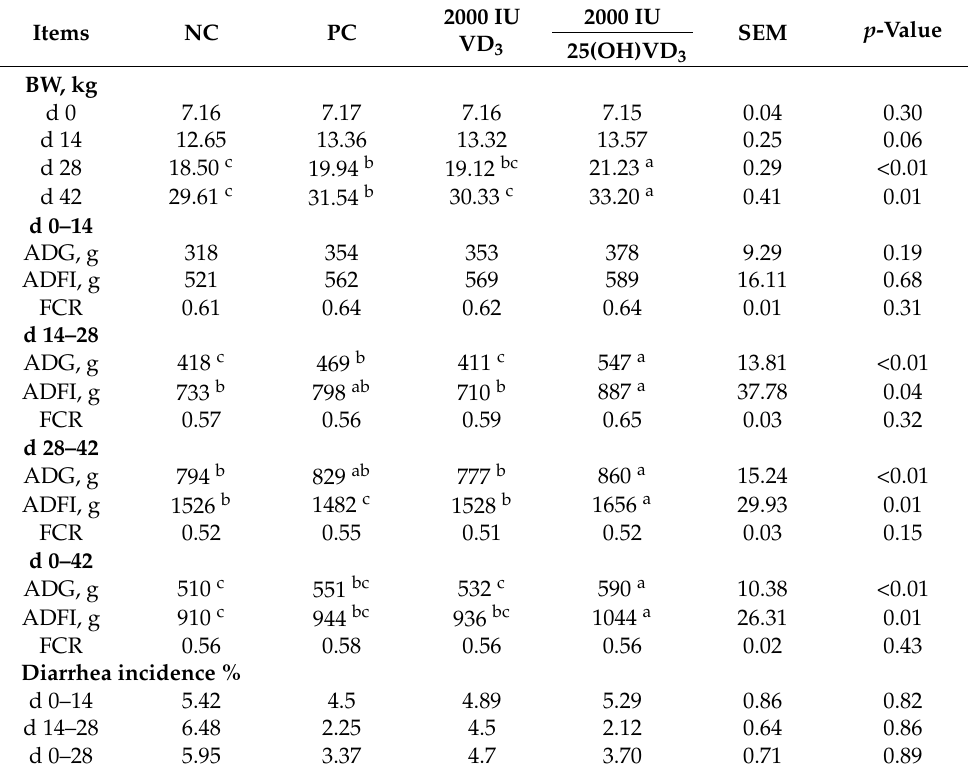
Table 2. Effect of dietary VD 3 and 25(OH)VD 3 supplementation on the growth performance of weaned piglets.